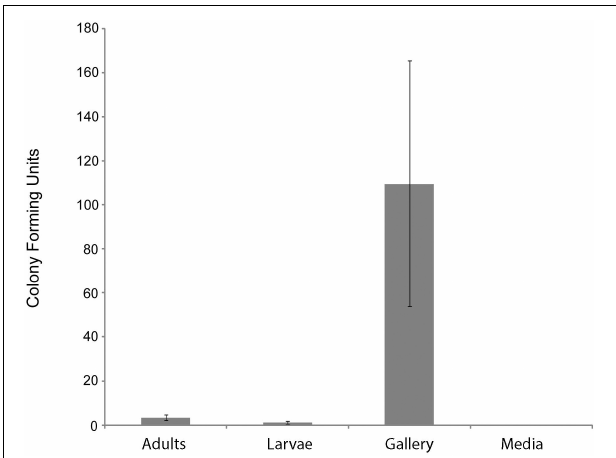
FIGURE 1 | Number of Actinobacteria cultured from components of X. saxesenii nests. Means ± standard errors of the mean are displayed. See methods for culture